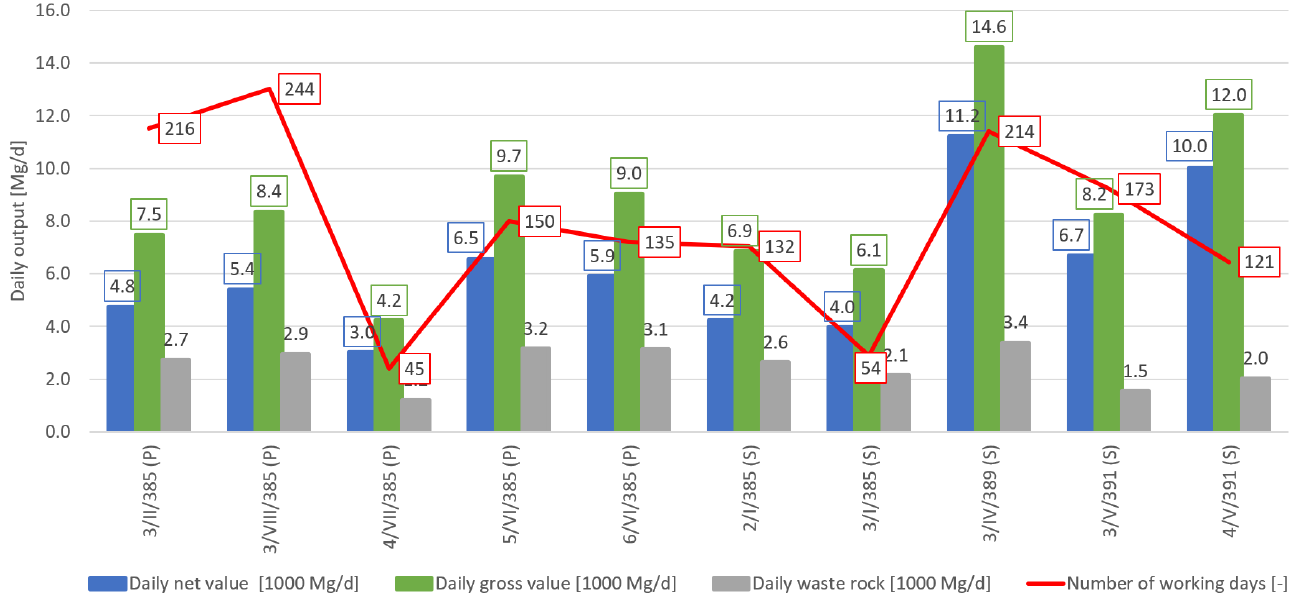
Figure 1. Total output and waste rock share for individual longwalls.